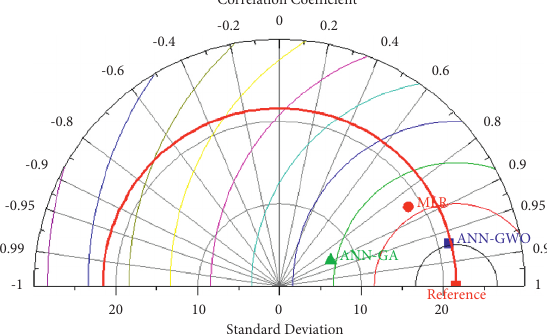
Figure 14: Comparison between models using normal distribution.